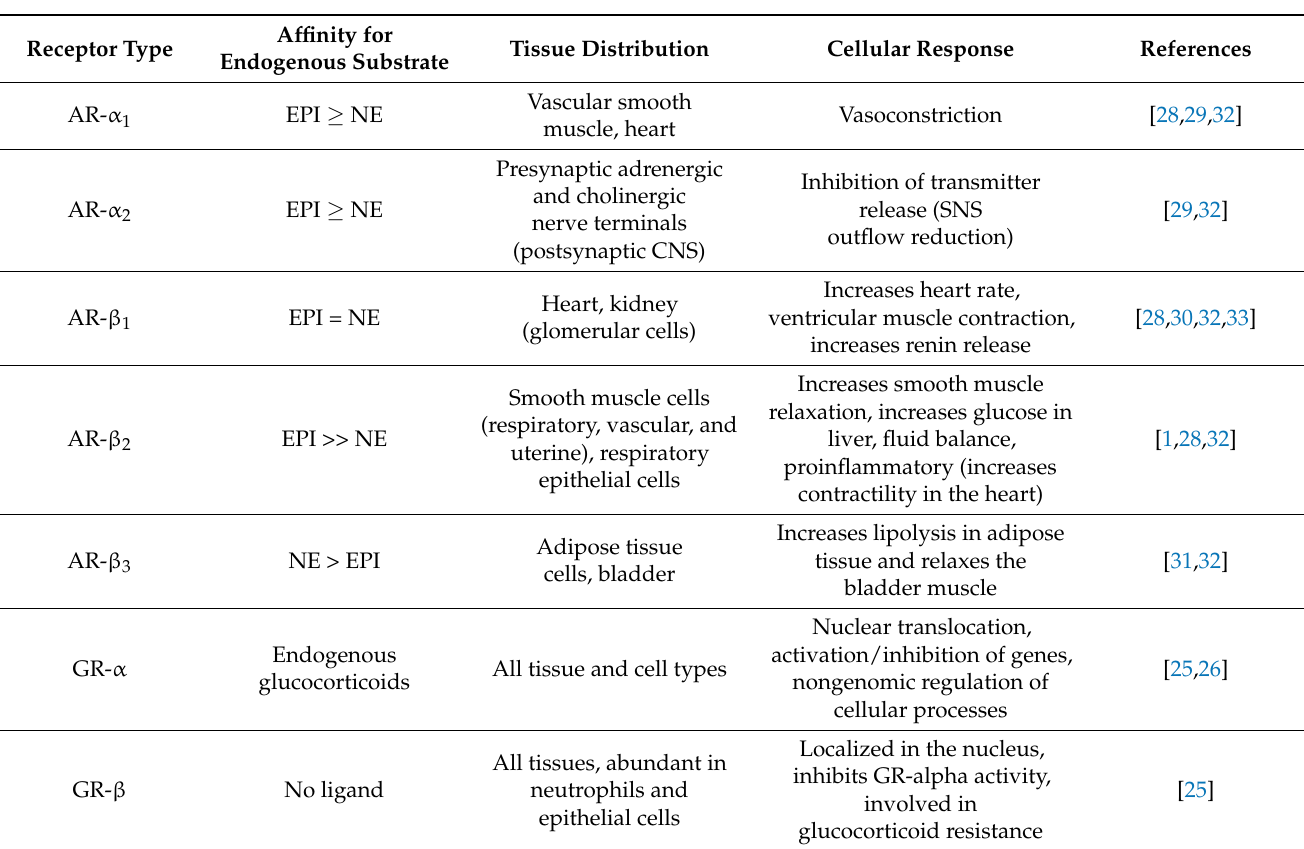
Table 1. Adrenergic (AR) and glucocorticoid (GR) receptor subtypes and their substrate preferences, tissue distribution, and cellular functions. AR and GR subtypes have been well characterized, and are widely manipulated therapeutically. Their wide but selective tissue distribution, efficacy for ligands, and receptor-subtype-specific functionality are critical in maintaining temporal and dynamic changes in biological processes to regulate homeostasis. EPI: epinephrine; NE: norepinephrine; CNS: central nervous system; SNS: sympathetic nervous